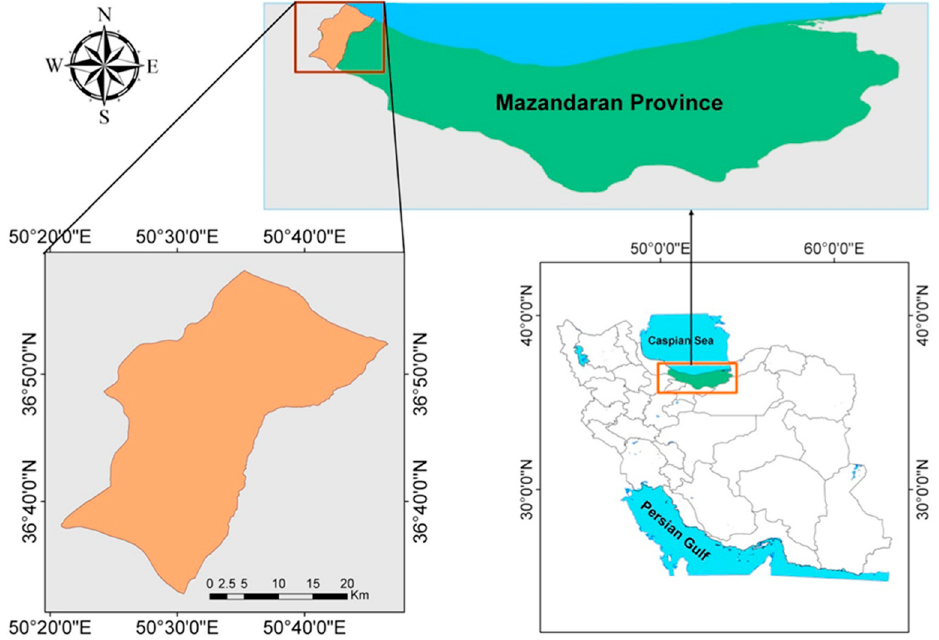
Figure 2. Geographical location of Ramsar area.